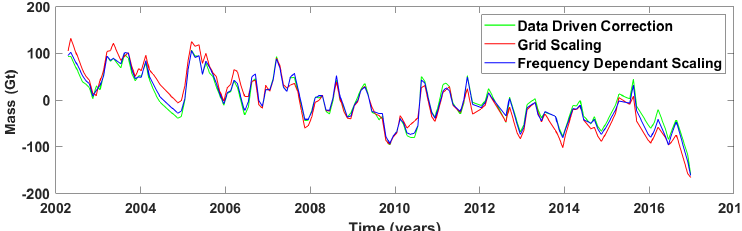
Figure 14. Basin-averaged GRACE time series for Indus Basin with corrected leakage using DDC, grid scaling, and frequency-dependent scaling using integrated